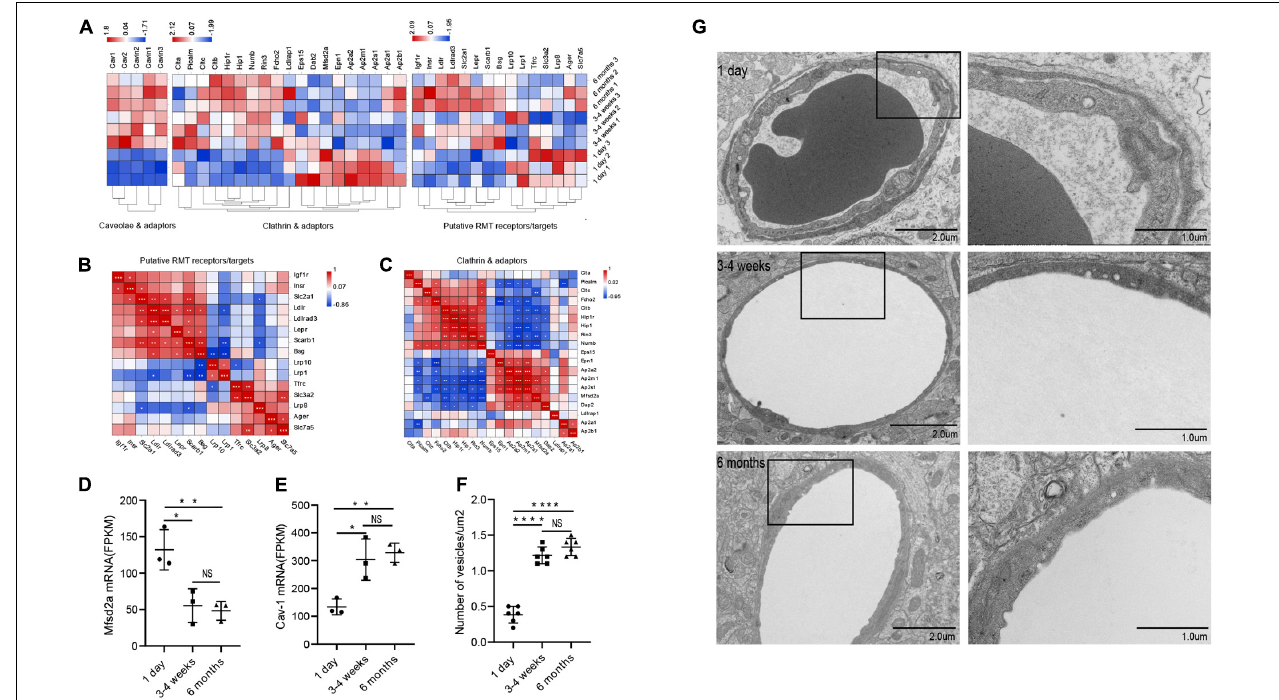
FIGURE 4 | Changes in microvascular endothelial transcytosis during development. (A) Microvascular endothelium gene expression of putative RMT receptors, clathrin adaptors and caveolae and caveolae inhibitor (CI). (B,C) The correlation heat map analysis of putative RMT receptors and clathrin adaptors. (D) The bar graph shows the expression trend of mfsd2a in RNA transcriptome sequencing ( n = 3). (E) The bar graph shows the expression trend of cav-1 in RNA transcriptome sequencing ( n = 3). (F) Quantification of the number of vesicles in EC ( n = 6). (G) Representative images of the ultrastructure of the microvasculature in the 1-day-old,